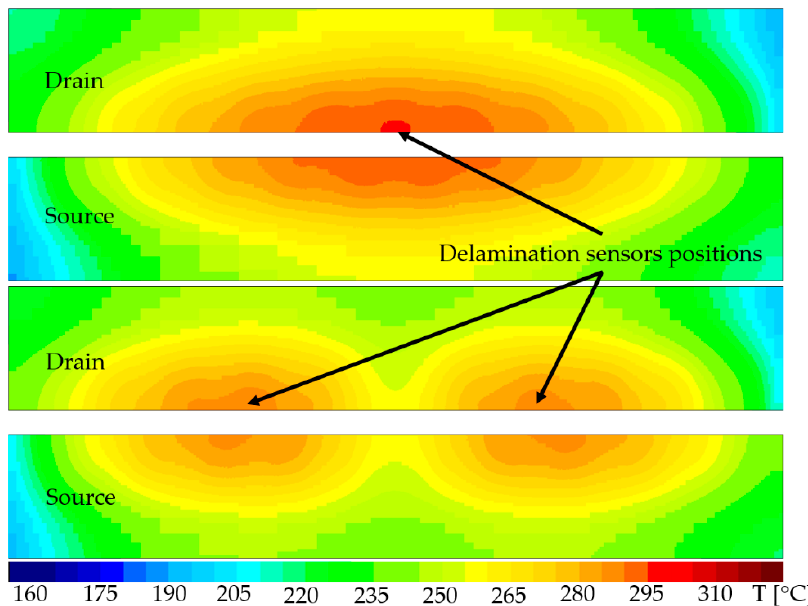
Figure 7. Delamination sensor placement with regards to peak temperature in PM top—100%AA, bottom—90%AA.